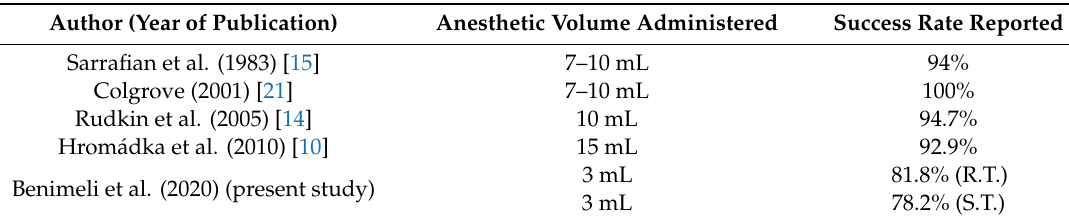
Table 5. Comparison of the success rates reported by other authors based on a high volume blocking with those obtained in the present study for the retromalleolar technique (R.T.) and supramalleolar technique